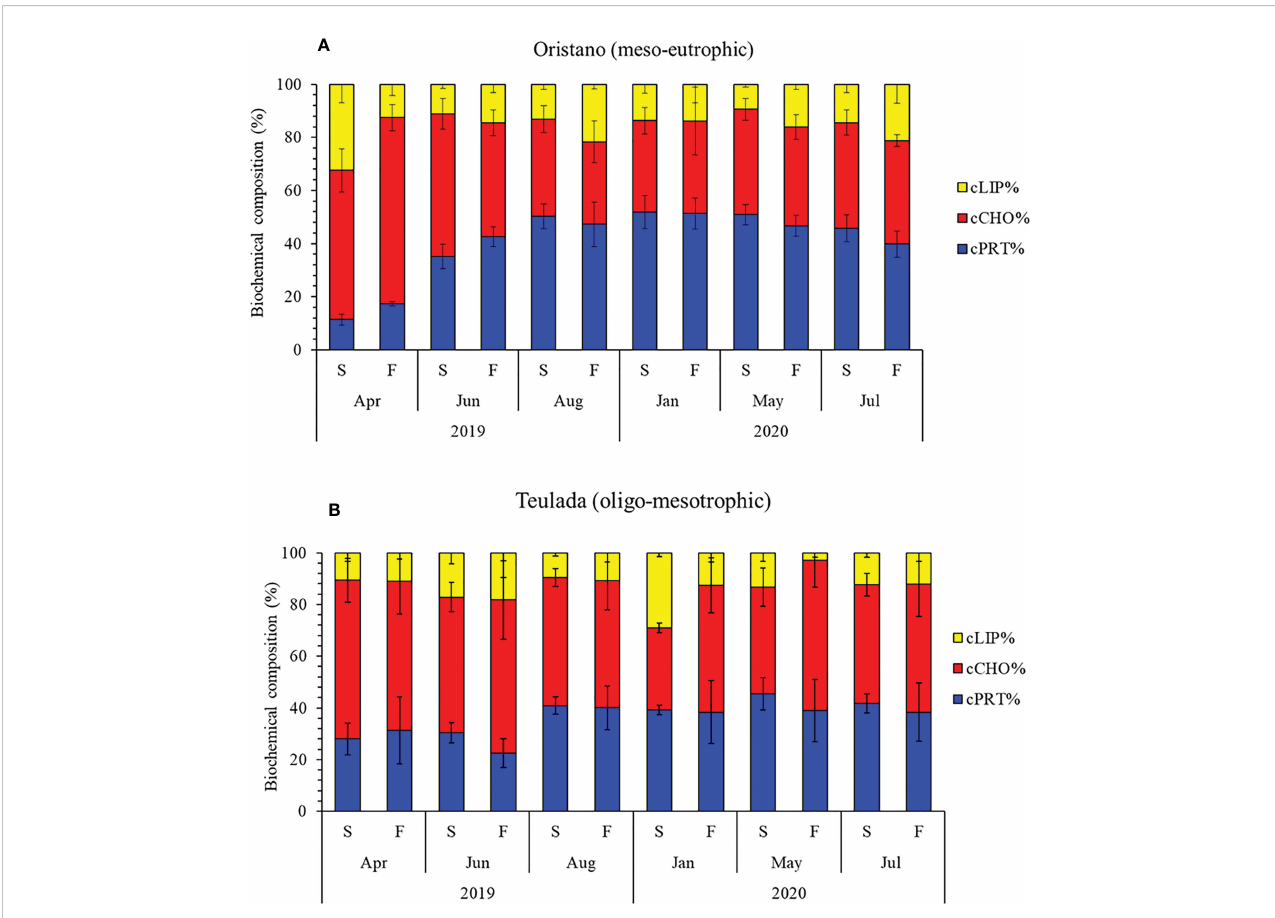
FIGURE 4 Variations in the percentage contribution of proteins, carbohydrates, and lipids to the BPC in sediments (S) and feces (F) in the organically enriched site of Oristano (A) and in the poorer site of Teulada (B) . Error bars indicate the standard error (sediments n=9; feces n=3). cLIP, lipid; cCHO, carbohydrate; cPRT,